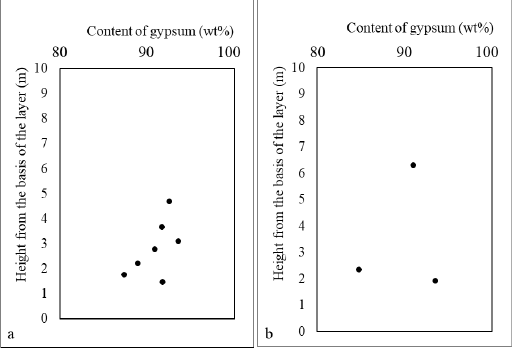
Figure 4. Distribution of percentage of gypsum content (by weight) along the vertical direction of the layer in the two boreholes, denominated S58 ( a ) and S61 ( b ), at Calliano quarry. The y-axis is oriented as the stratigraphic layer, with the top of the layer in the higher part of the Figure. Along the vertical direction of borehole S61, three samples were taken for composi- tional analyses with XRPD and EDS. Results are shown in Figure 5, with the additional indication of sample positions in the SKB layer (Figure 5g). XRPD analyses, performed on the non-gypsum portions of the material, revealed the presence of calcite as a common feature in all the samples. In the upper part of the layer (Figure 5a), no other minerals were detected besides gypsum. Consistently, Figure 5b, showing the EDS map performed in the same stratigraphical position, highlights the main rock organization with large crys- tals of gypsum (in blue in the image) and smaller calcite grains in the pores (in green). In the central portion of the layer (Figure 5c,d), aside from calcite, the analyzed pow- der samples contain quartz, feldspar and clay minerals. Similar to the higher parts of the layer, calcite (in green) mainly consists of grains of a few tens of microns that, in Figure 5d, are organized in layers that locally border the gypsum nodules. On the other hand, clays, feldspars and quartz appear to be fine-grained and represent the main part of the material in the thin layers of the branching structure. As shown in Figure 5d, indeed, these layers mainly consist of Si (yellow), K (fuchsia), Al (orange), Mg (violet) and Fe (red). The violet mineral in the Figure, consisting of the sum of Fe (red) and S (blue), is pyrite. This mineralogical composition and organization of the rock (with nodules of gyp- sum, layers of fine-grained terrigenous minerals and, sometimes, equigranular calcite) is the most common in the rock. It is, indeed, still present in the lower part of the borehole (Figure 5e,f). In these portions of the layer, however, a lower content of calcite is registered by the XRPD patterns. Consistently, the calcite crystals observed in the sample in Figure 5d are not ubiquitous in this rock portion, as confirmed by the absence of calcite in the EDS map in Figure 5f.